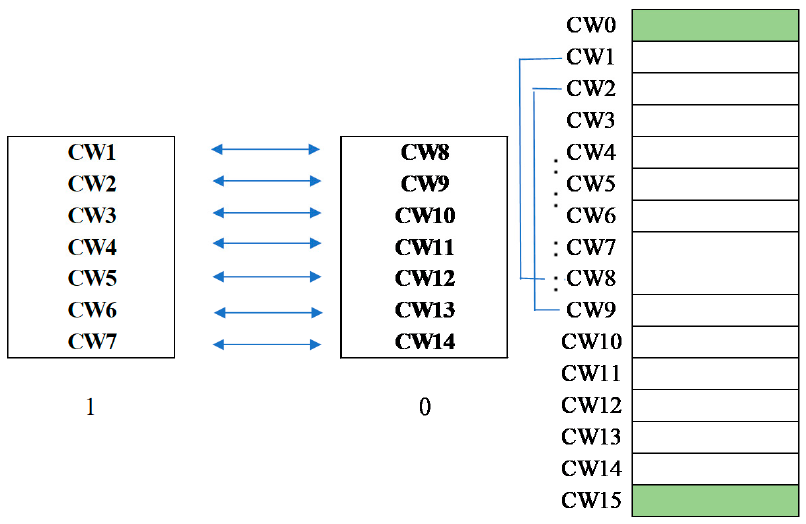
Figure 6. An illustration of codewords clustering.